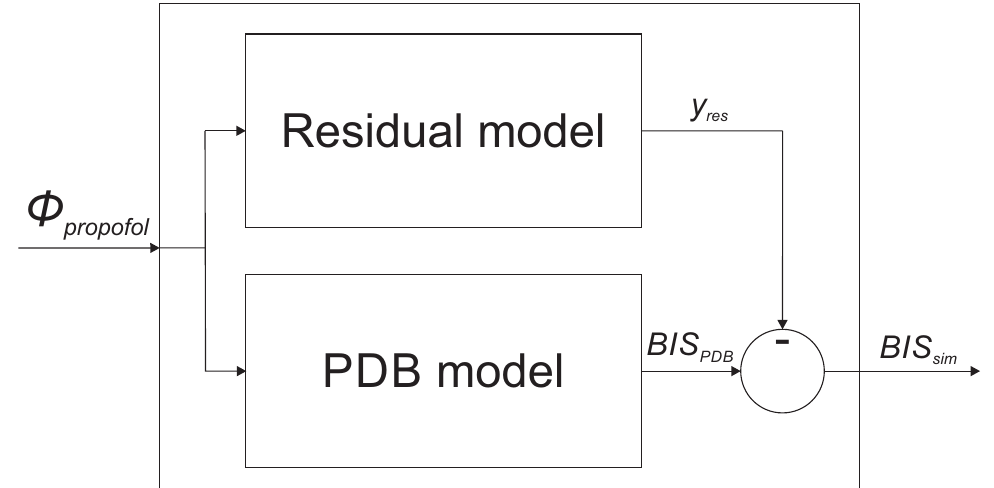
Figure 1. The improved model structure consisting of the population-data-based (PBD) model, and the residual dynamic